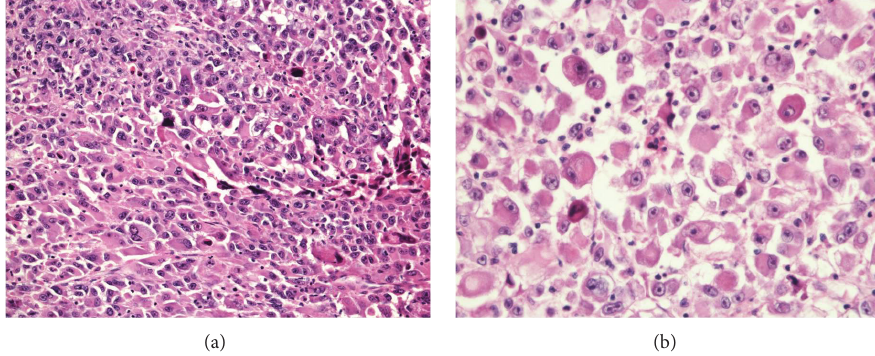
Figure 6: Histopathology of tumor. (a) The tumor cells are arranged in solid sheets and show pleomorphic nuclei with prominent nucleoli (H&E, × 100). (b) Some tumor cells have eccentric nuclei with abundant cytoplasm (H&E, ×